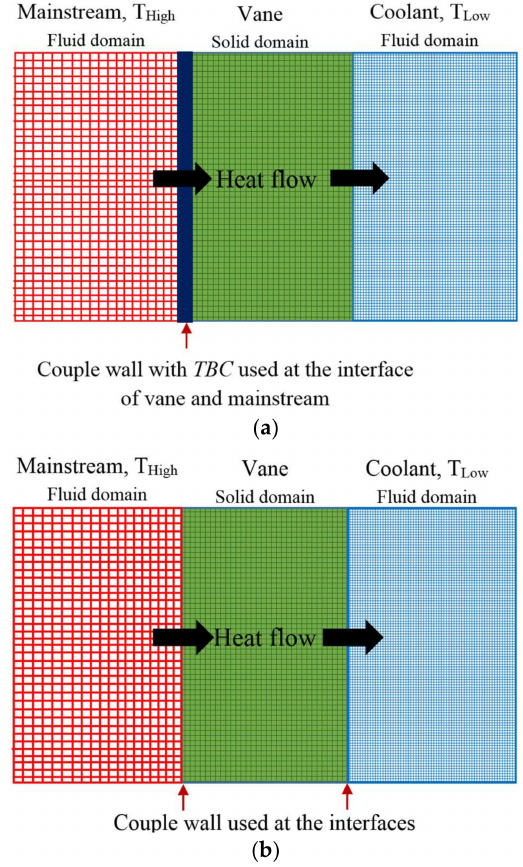
Figure 6. Interface technique with a couple wall, ( a ) without and ( b ) with thermal barrier coating (TBC)